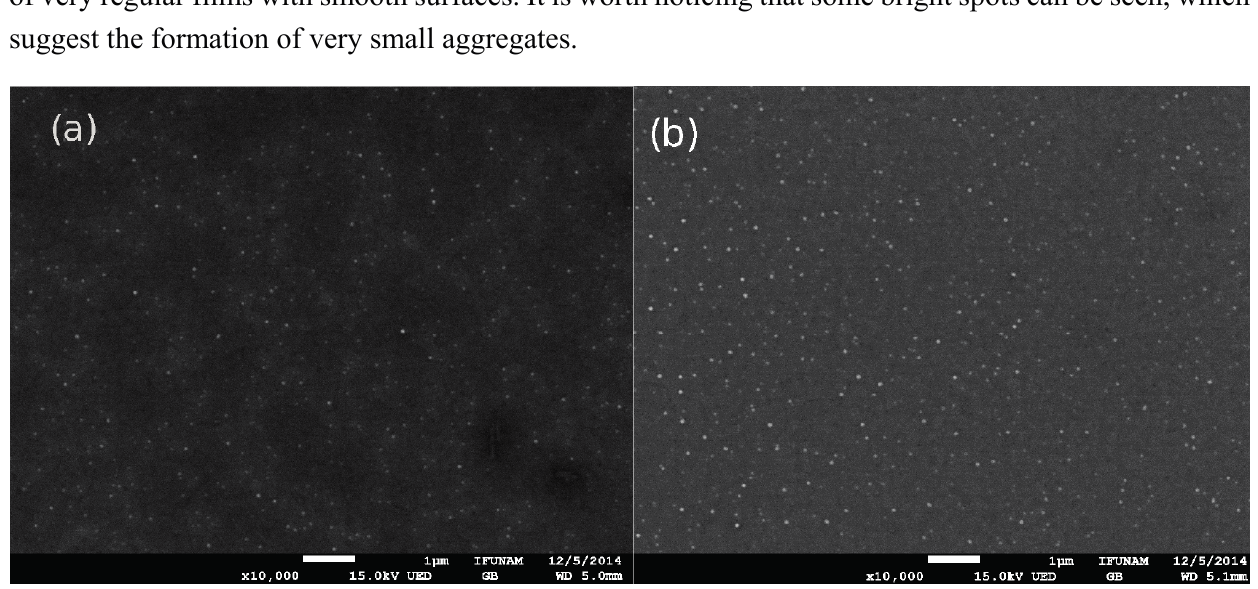
Figure 5. Scanning electron microscope (SEM) images of films obtained from compounds ( a ) 3 and ( b ) 4 . Magnifications are 10,000× in both